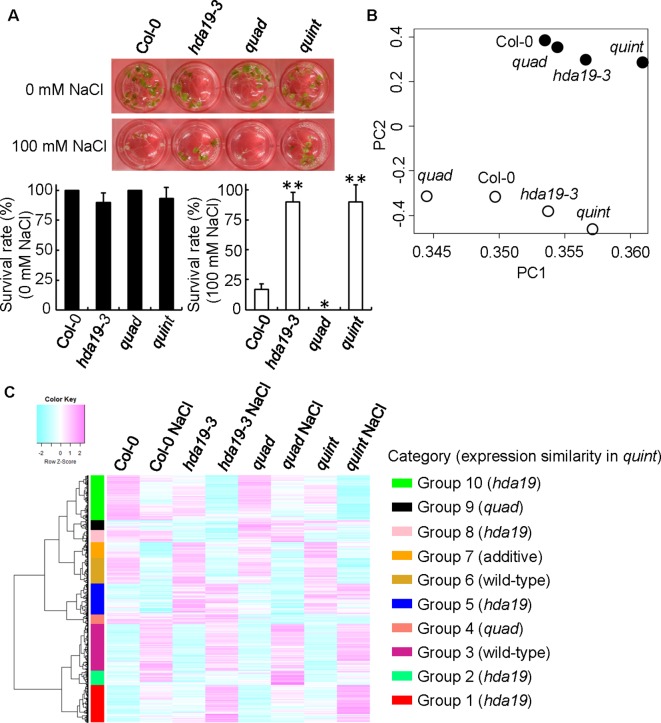
Microarray analysis of genome-wide transcription in Col-0, hda19-3, quad, and quint plants under non-stressed and salinity-stressed growth conditions. (A) The survival rate (in percent) of each plant was evaluated 4 days after treatment with 100 mM NaCl or without NaCl (means ± SD; n = 3, where each biological replicate was a collection of 10 plants). P values were calculated using Student’s t test (*P < 0.05 and **P < 0.01). (B) Principal component analysis (PCA) based on whole-genome transcriptome analysis. Filled and open circles reflect the expression profiles under normal and salinity growth conditions, respectively. (C) Hierarchical cluster analysis of salt-responsive genes. The genome-wide mRNA profiles determined by microarray analysis were obtained from 5-day-old plants treated with or without 125 mM NaCl for 2 h. Transcript data were generated from three biological replicates. The heat map represents the Z score, with bars showing values from −2 to 2. Red represents upregulated genes, while blue represents downregulated genes. Genes with a significant change in expression were selected using the following criteria: an expression log_2 ratio >0.5 and a controlled p value (FDR; Benjamini and Hochberg, 1995) from a t test analysis <0.05.